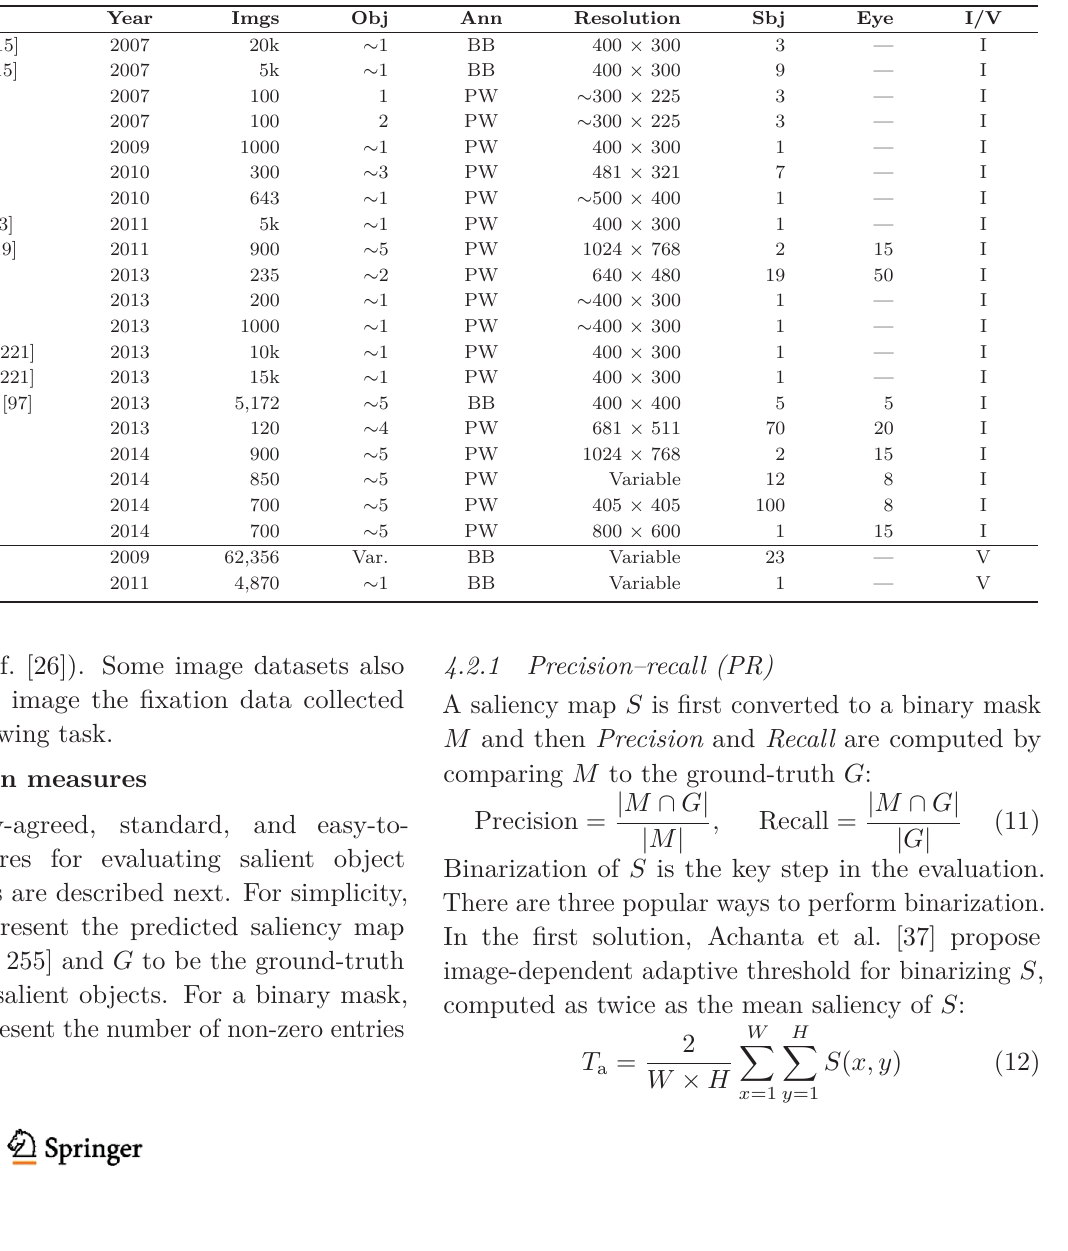
Fig. 6 Sample applications of salient object detection. Table 6 Overview of popular salient object datasets. Above: image datasets, below: video datasets. Obj: objects per image, Ann: Annotation, Sbj: Subjects/Annotators, Eye: Eye tracking subjects, I/V: